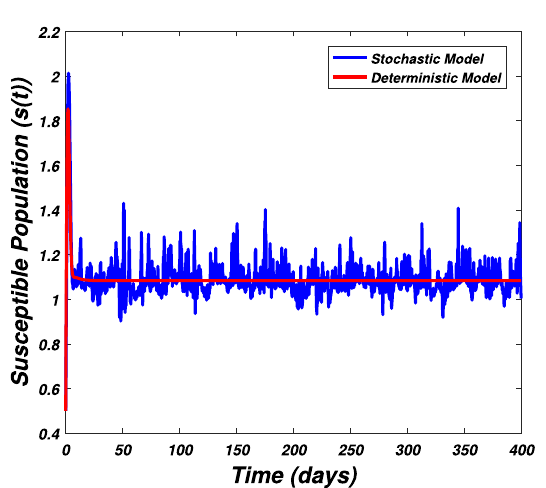
Figure 10. The graph visualizes the dynamics of the epidemic problem described by the model (1) in the case of persistence for the susceptible class ( s ( t )) against the values of the parameters taken from S 2 and (0.5, 0.3, 0.2, 0.1) are the initial sizes of